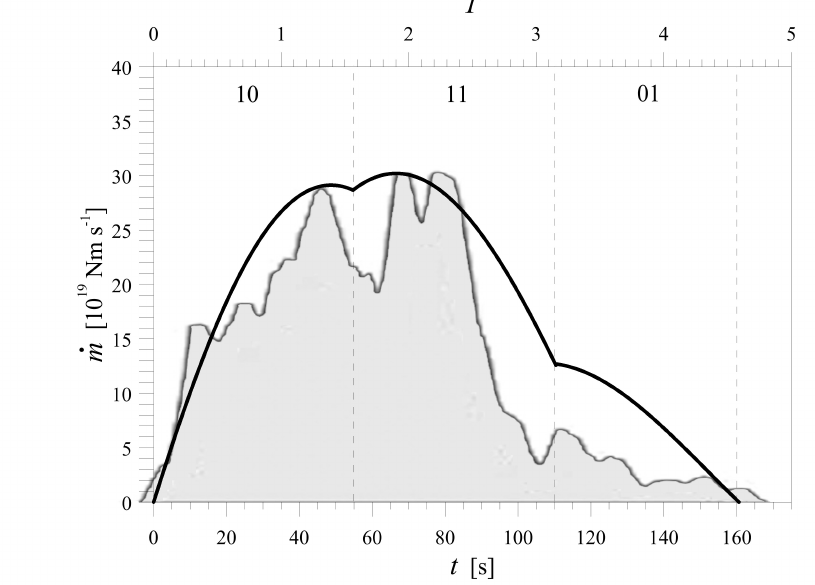
Figure 4. The moment rate ˙ m as a function of time, calculated for the 2010 Maule event (solid curve) superimposed to that retrieved from data by [1] (grey filled